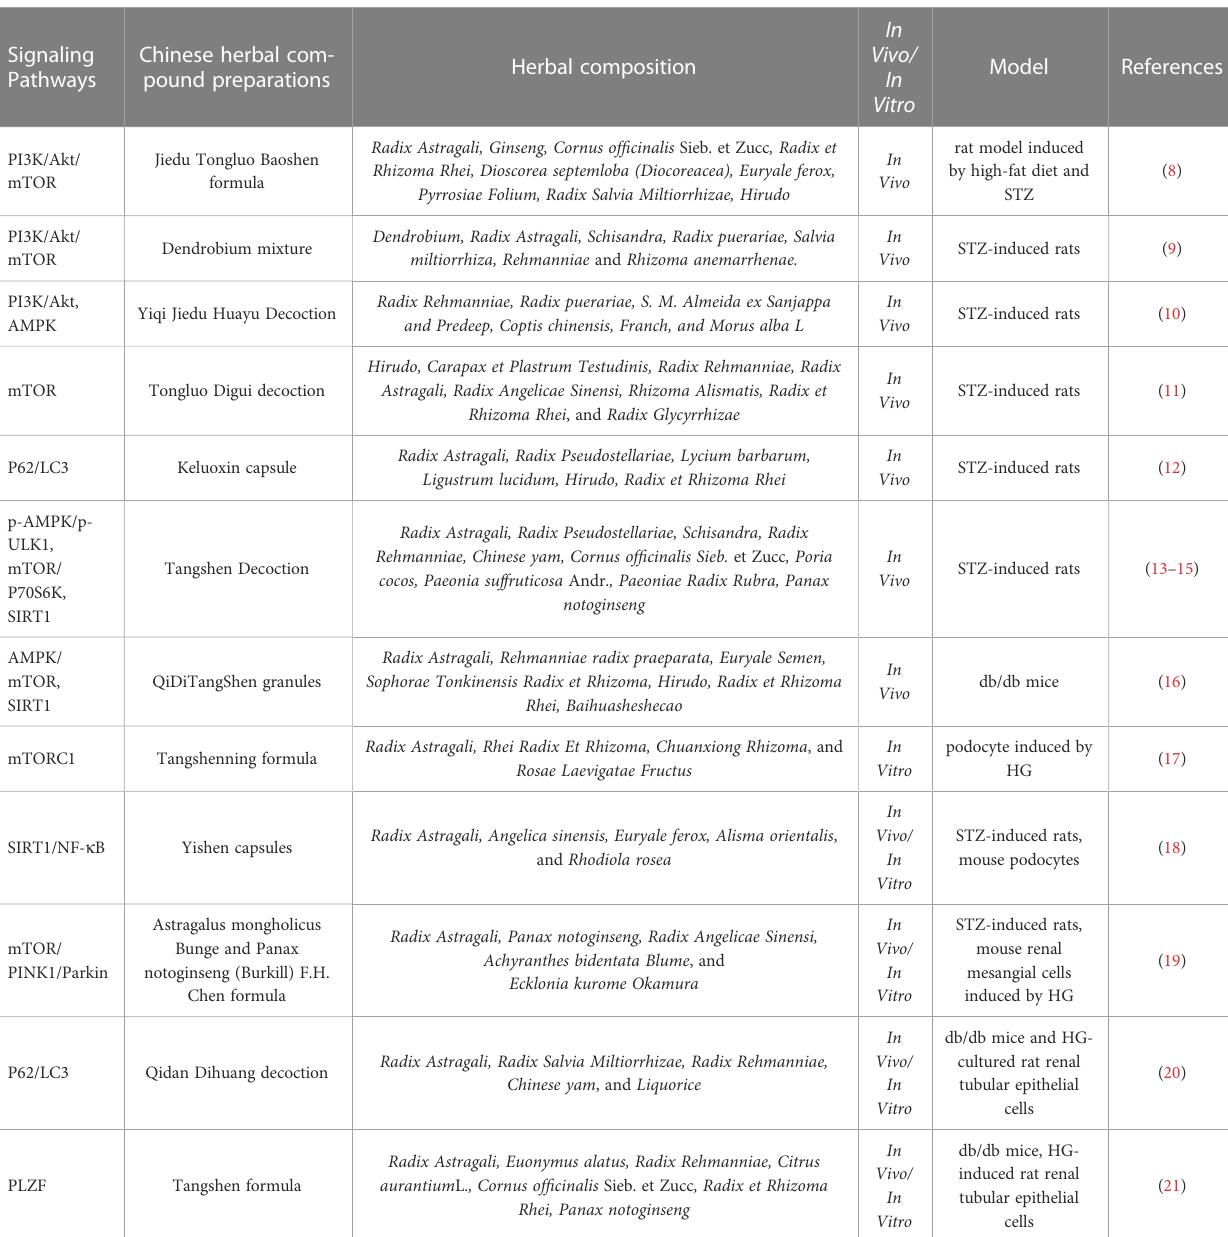
TABLE 1 The role of Chinese herbal compound preparations against renal injuries via regulating autophagy in DKD.